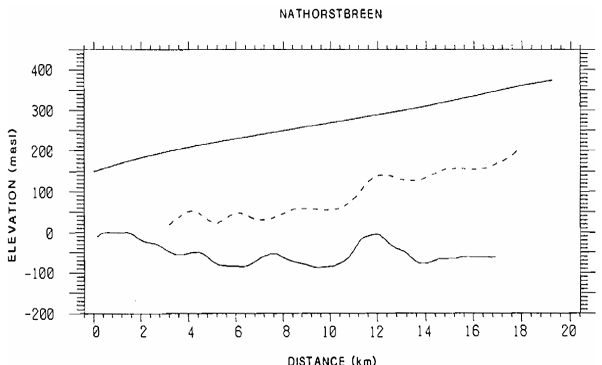
Fig. 9. Radio-echo sounding profile along Nathorstbreen (location in Fig. 1) from Dowdeswell et al. (1984), with permission from the Norwegian Polar Institute. The dashed line indicates the boundary between cold ice (upper) and temperate ice